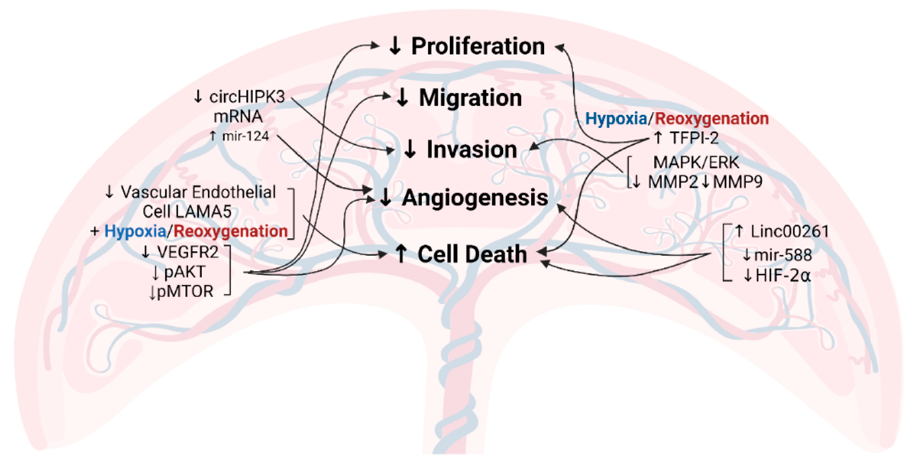
Figure 2. Identified and proposed mechanisms for abnormal placental development in preeclampsia [49–59] (circHIPK3, circular RNA homeodomain interacting protein kinase 3; LAMA5, laminin subunit alpha-5; VEGFR2, vascular endothelial growth factor receptor 2; pAKT, phosphorylated protein kinase B; pMTOR, phosphorylated mammalian target of rapamycin; TFPI-2, tissue factor pathway inhibitor-2; MAPK, mitogen-activated protein kinase; ERK, extracellular-signal-regulated kinase; MMP, matrix metalloproteinase; HIF-2 α , hypoxia-induced factor-2 α ; ↑ refers to upregulation; ↓ refers to downregulation).